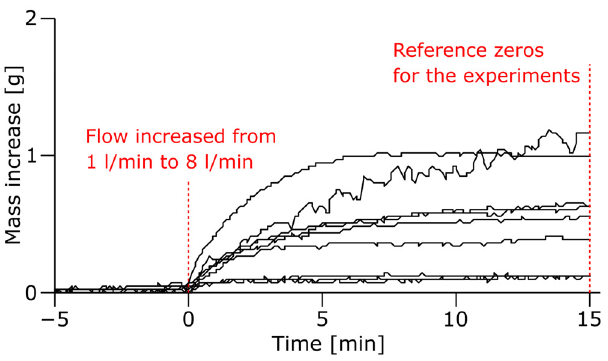
Figure 6. Measured mass increase after flow change from 1 L/min to 8 L/min argon.